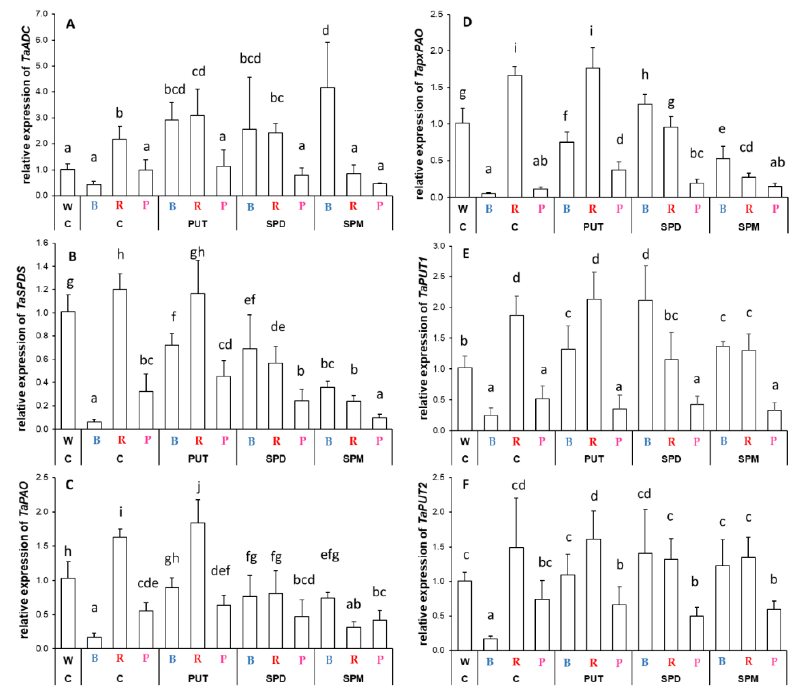
Figure 7. Gene expression patterns of arginine decarboxylase (( A ): ADC ), spermidine synthase (( B ): SPDS ), peroxisomal polyamine oxidase (( C ): pxPAO ),polyamine oxidase (( D ): PAO ) and polyamine uptake transporter genes (( E ): PUT1 and ( F ): PUT2 ) in the leaves of plants grown under different light regimes (white light: W, blue light: B, red + far-red: R and the combination of blue and red + far-red, pink: P) treated with or without polyamines (control: C, putrescine: PUT, spermi- dine: SPD and spermine: SPM). Values are means ± SD. All reactions for gene expression analyses were performed in triplicate using 3 biological and 3 technical repetitions. Different letters indicate statistically significant differences at p < 0.05 level, using Duncan’s post hoc